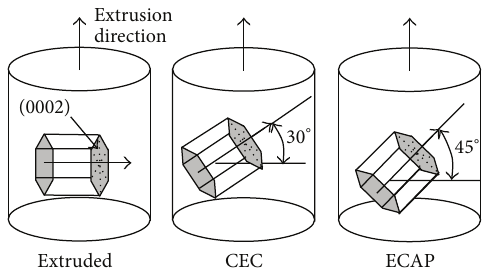
Figure 5: Schematic showing the dominant texture in the extruded ECAP and CEC conditions.